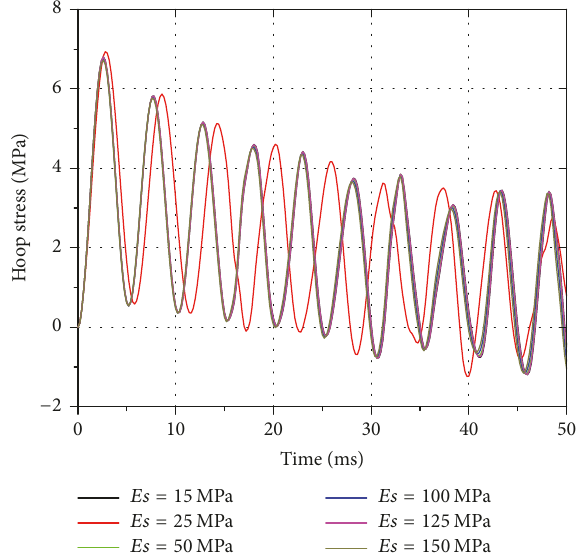
Figure 6: The influence of ground material’s Young’s modulus on hoop stress of centre